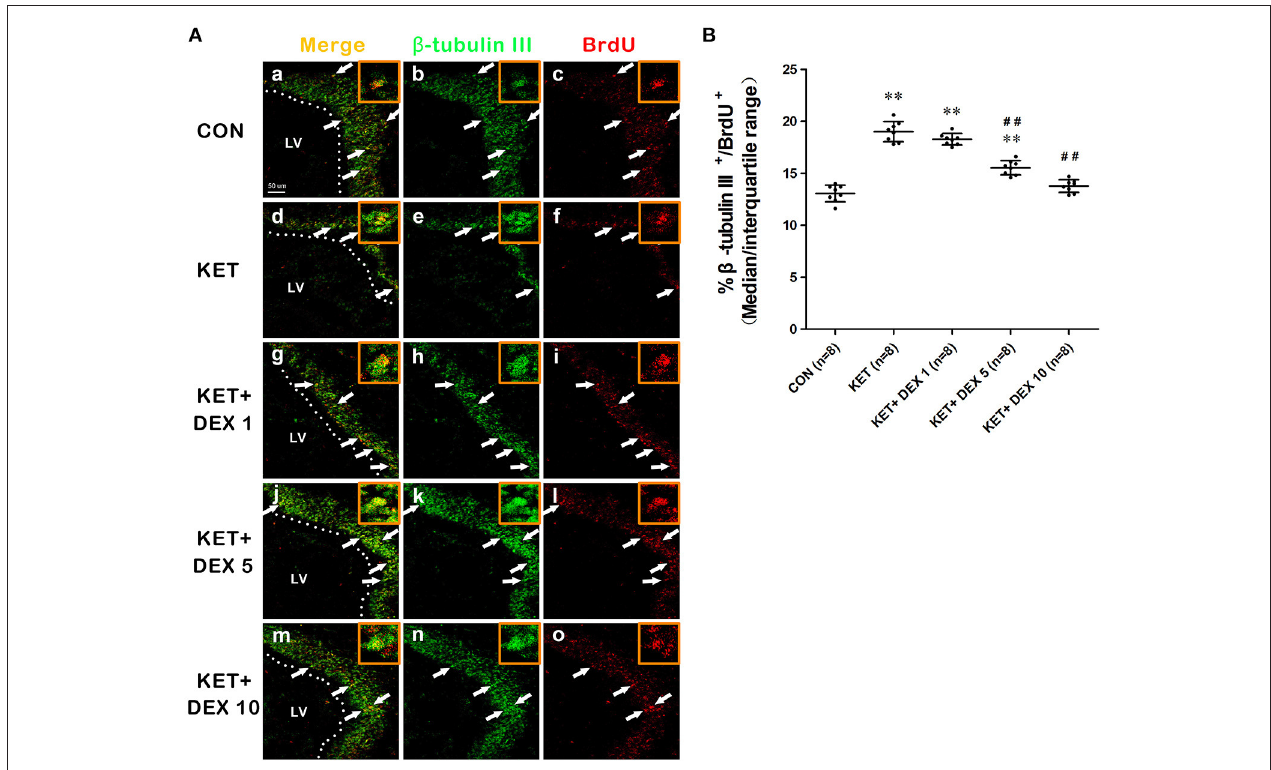
FIGURE 2 | The effects of ketamine (KET) and dexmedetomidine (DEX) on the neuronal differentiation of neural stem cells (NSCs) in the SVZ. Neonatal rats were pretreated with different doses of DEX via intraperitoneal injection prior to ketamine anesthesia for 30min. (A) Representative images of neuronal differentiation (BrdU, red; β -tubulin III, green) were captured using a laser scanning confocal microscope (magnification × 400, scale bar: 50 µ m). The arrows point to postively labeled cells. (B) The proportion of β -tubulin III + /BrdU + cells per SVZ in the different groups is shown. Data are presented as the means ± SD (eight tissue sections per group). ** p < 0.01 compared with the Control group; ## p < 0.01 compared with the KET group. SVZ, subventricular zone; LV, lateral